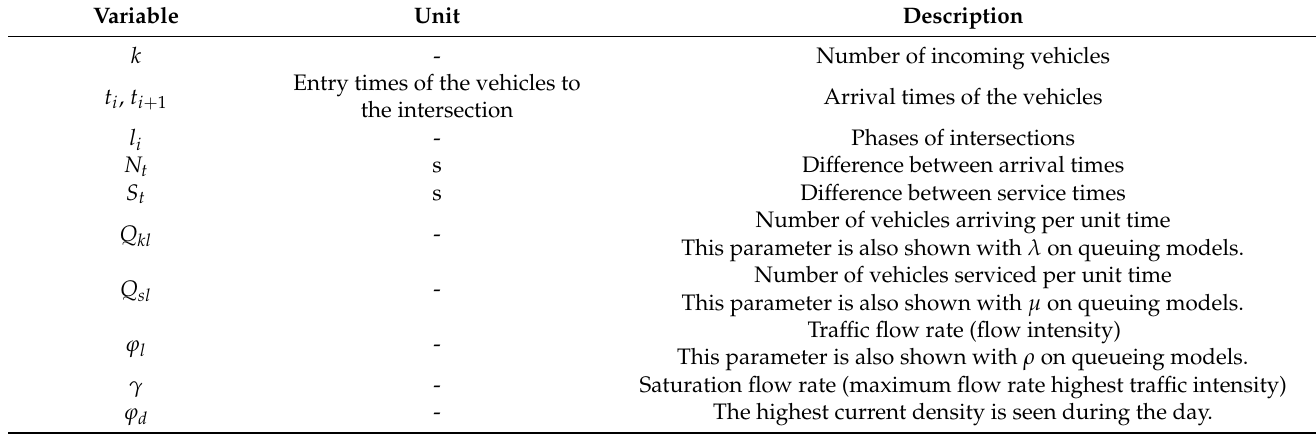
Table 4. Description of relevant variables.